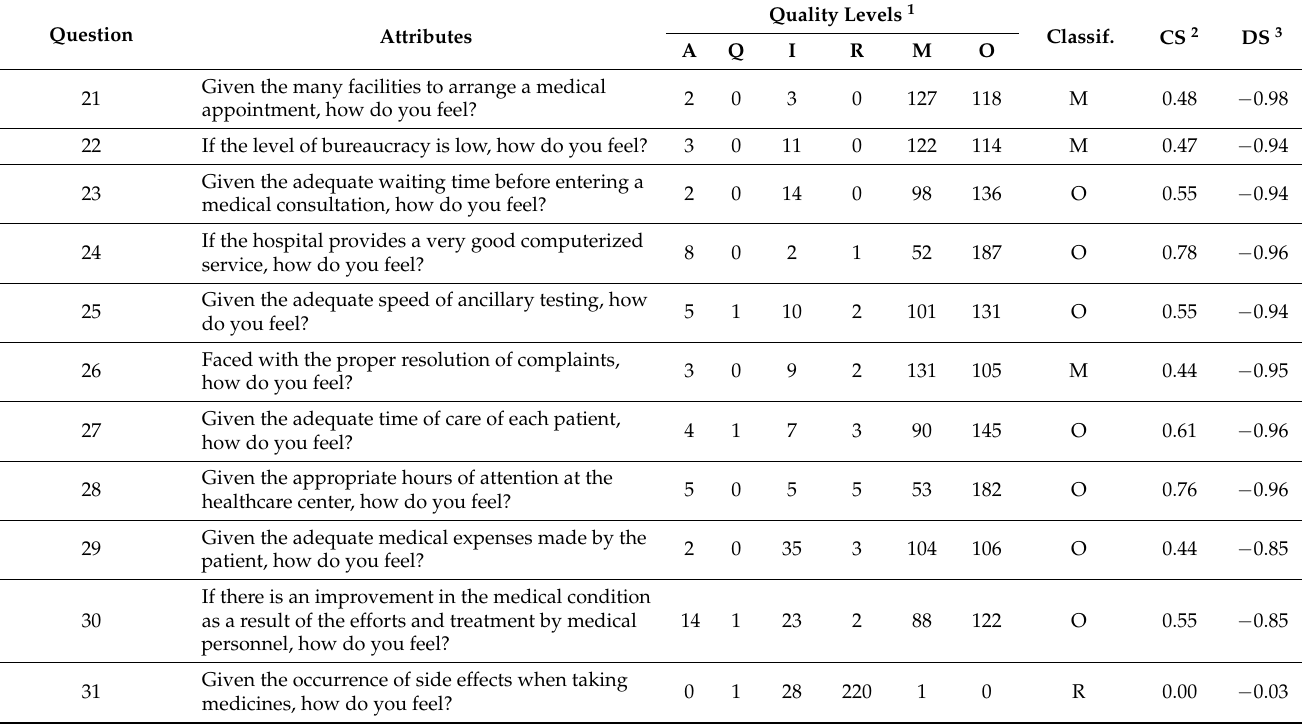
Table 7. Results corresponding to the efficiency